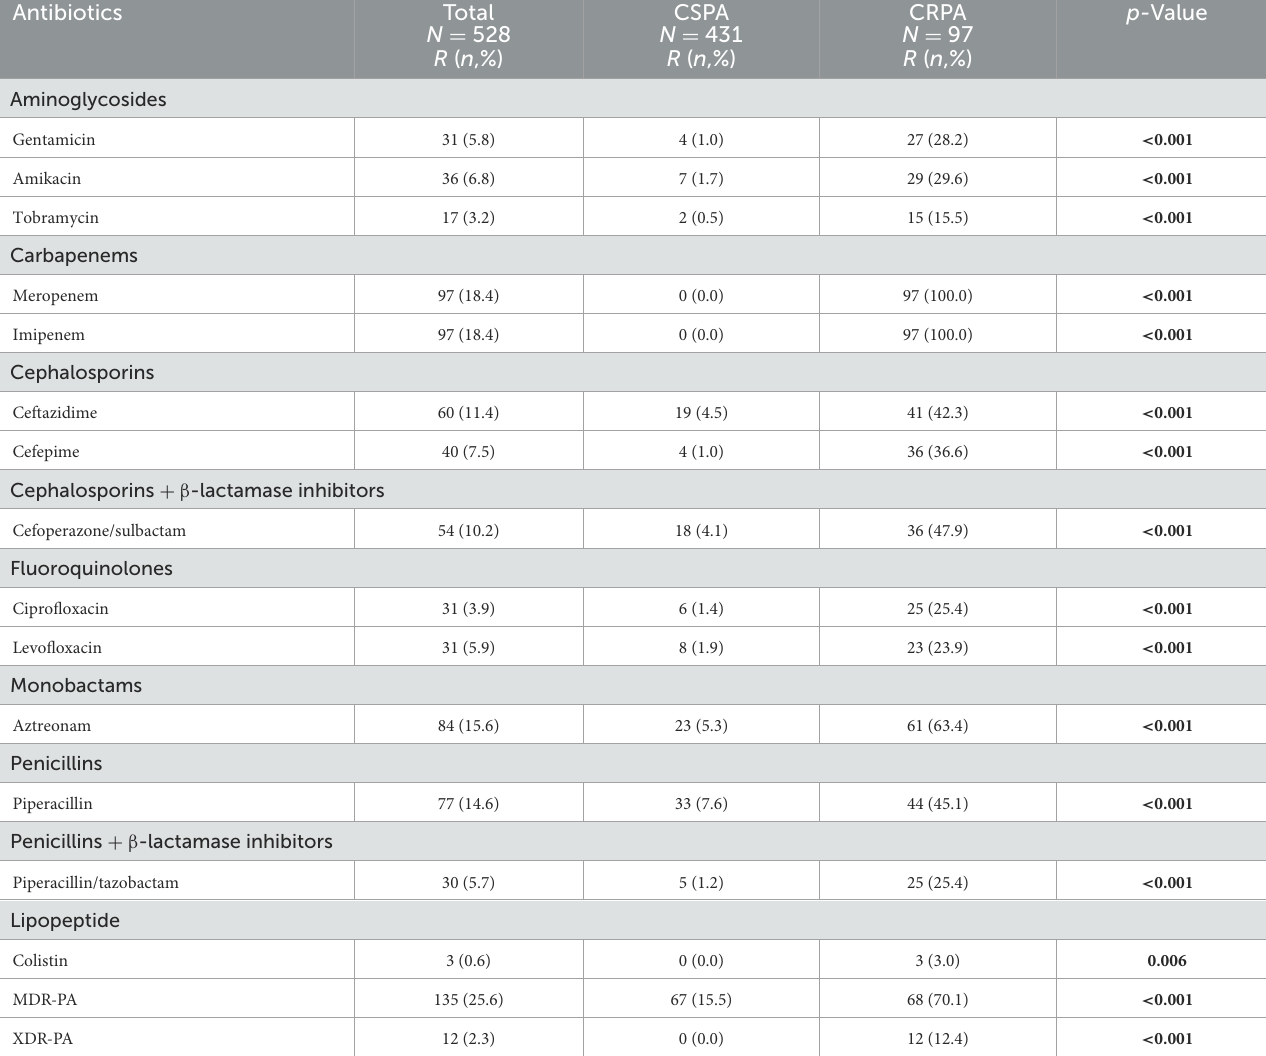
TABLE 1 The antimicrobial resistance of Pseudomonas aeruginosa strains in this study. Antibiotics Total